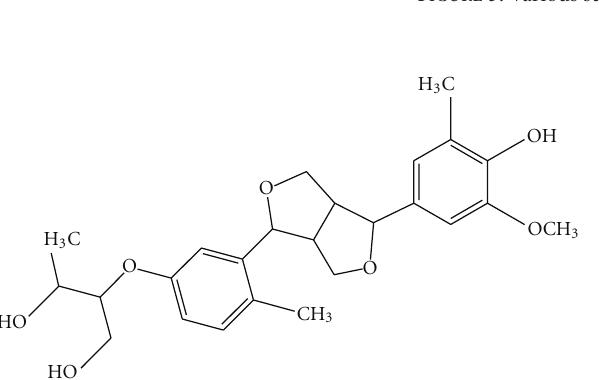
Figure 3: Various sugars of hemicelluloses.